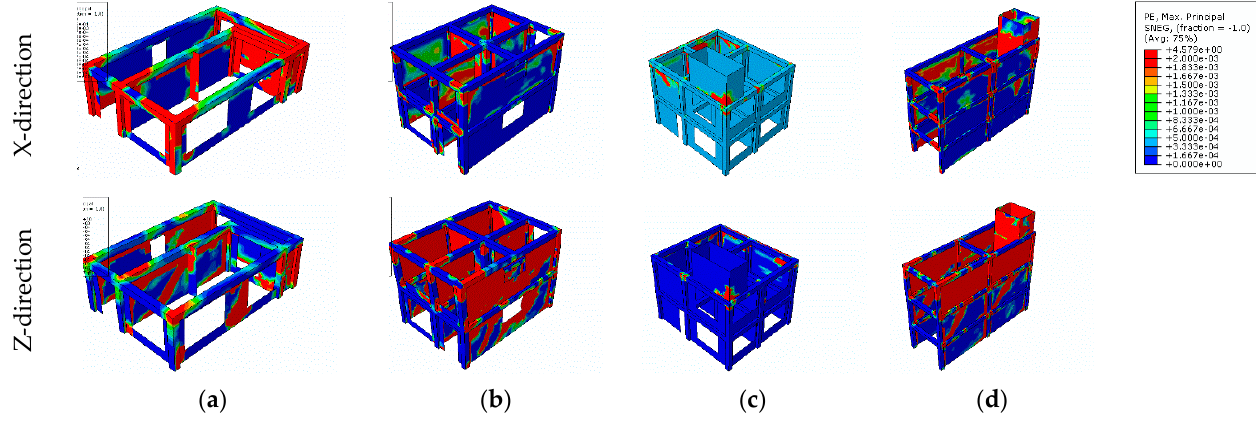
Figure 10. Push-over-based fragility curves of the URM models: ( a ) Type-1; ( b ) Type-2; ( c ) Type-3; ( d ) Type-4.